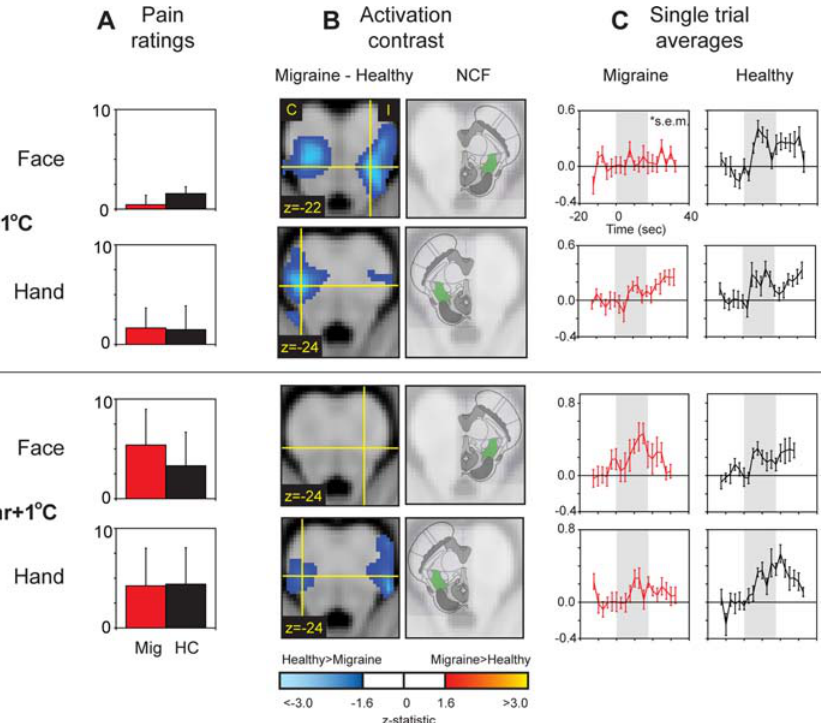
Figure 1. Functional differences in the brainstem and the brain of migraine vs. healthy control subjects. (A) Pain ratings: No significant effects of group or stimulation site for 41 u C (2-Way repeated measures ANOVA [group, site], group F=0 ? 3646, p=0 ? 5521, df=1, site F=2 ? 7355, p=0 ? 1123, df=1) and Thr + 1 u C (2-Way repeated measures ANOVA [group, site], group F=0 ? 2918, p=0 ? 5950, df=1, site F=0 ? 4060, p=0 ? 5312, df=1). Mig=migraine subject; HC=healthy control. (B) Activation contrast: Interictal migraine subjects show decreased nucleus cuneiformis (NCF) responses to stimuli relative to controls. The exception is Thr + 1 u C on the face. The green area in the reference images highlight NCF (adapted from Duvernoy[46]). C=contralateral to stimulus site; I=ipsilateral. p , 0 ? 05 (uncorrected). (C) Single trial averages: Responses recorded from anatomically defined NCF region of interest. Y-axis=normalized % signal change. Gray shade represents stimulus application. N=12 in each condition, except for Thr + 1 u C for Face (N=11). One patient was excluded because of stimulus-correlated motion; the corresponding control was also excluded.